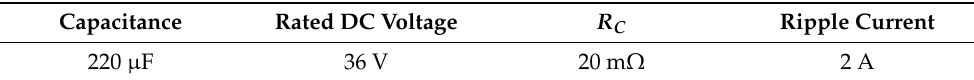
Table 4. Capacitor’s main parameters summarized from the datasheet presented by Panasonic ® in